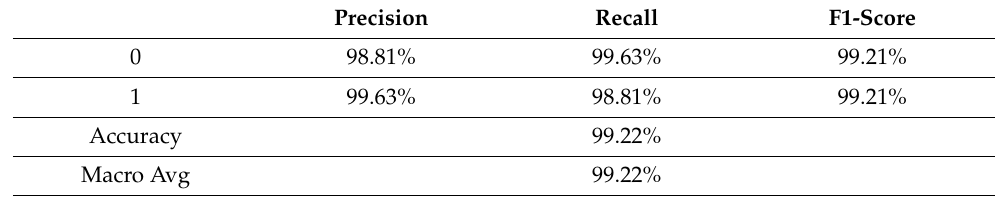
Table 4. The performance of the proposed model for binary classification task.